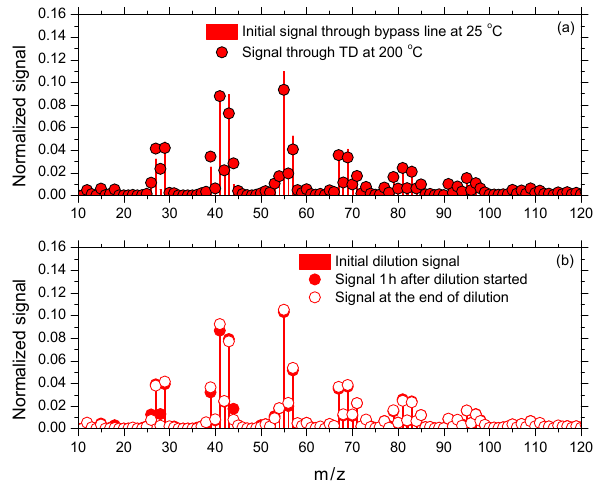
Figure 5. (a) Normalized HR-ToF-AMS mass spectra of the initial measurements at ambient temperature through the bypass line (red bars) compared to those measured in the TD at 200 ◦ C (red circles). (b) Normalized HR-ToF-AMS mass spectra at the onset of dilution experiment (red bars) compared to those measured after 1h (solid circles) and to those measured at the end of the experiment (open